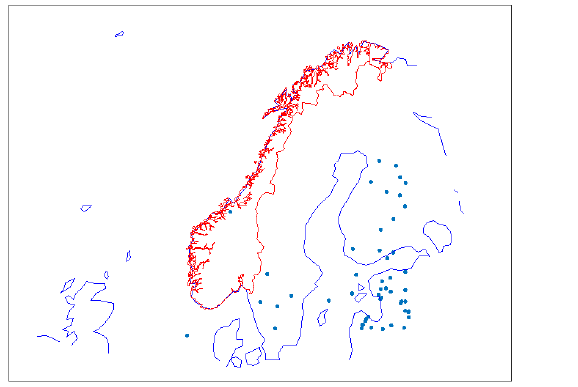
Figure 6. Fifty events with the highest dZTD